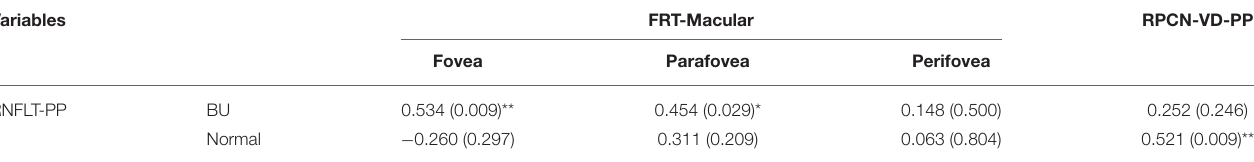
TABLE 7 | The Results of Pearson Correlation Analyses between RNFLT and Macular FRT/ RPCN Vascular Density in BU and Normal Eyes.